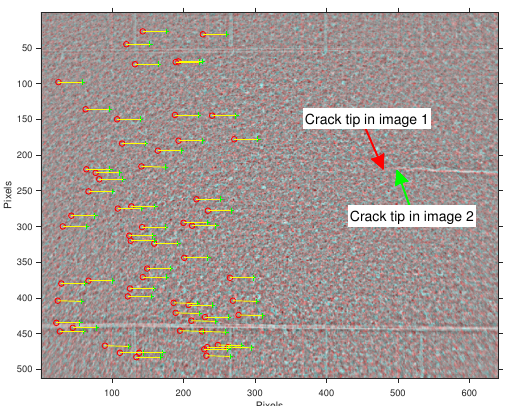
Figure 7. Illustration of FAST points used to find camera motion between two successive